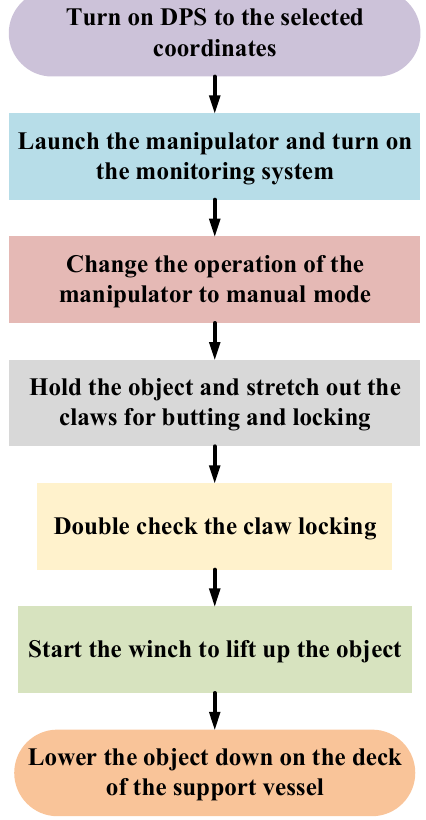
Figure 12. Flowchart of the manipulator operation process.